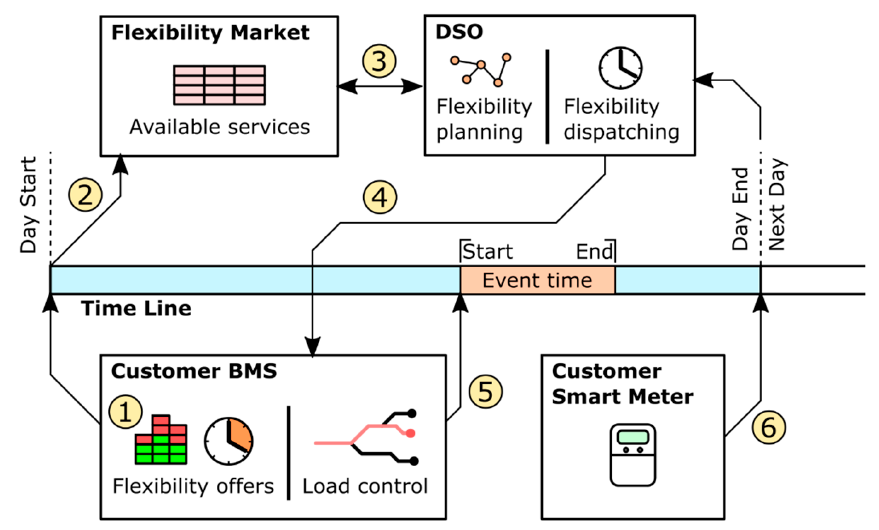
Figure 5. Complete flexibility cycle. (1) Flexibility offers calculation [BMS]; (2) Send offers to market [BMS-Market]; (3) Services selection [DSO-Market]; (4) Service request [DSO-BMS]; (5) Load control for requested service [BMS-Loads]; (6) Auditory of the requested service [DSO].